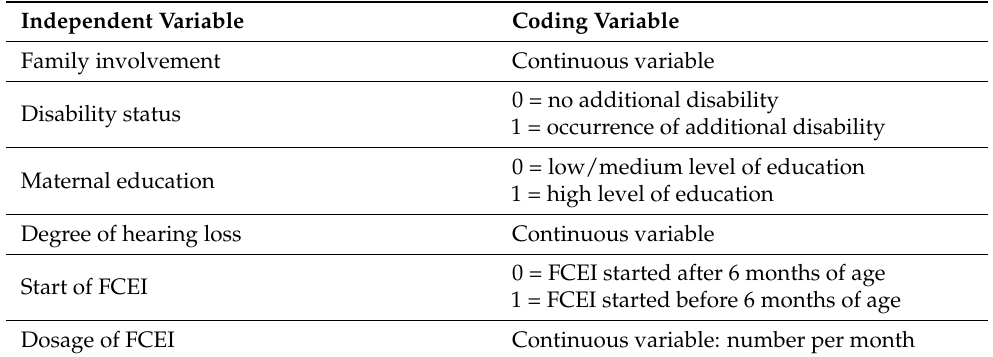
Table 1. Description of the coding of the independent variables in the multiple regression models.